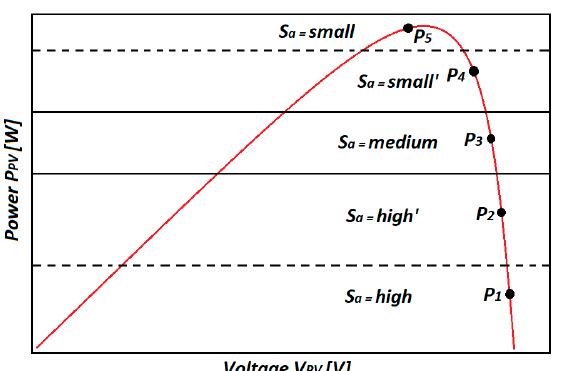
Figure 15. Power-Voltage characteristics of the PV panel with FLC based on 5 points of optimiza-